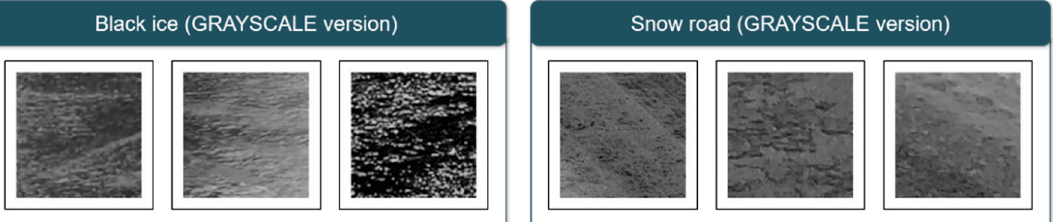
Figure 8. GRAYSCALE version of train data (black ice and snow road); relative to the data in the previous figure, the reflection of black ice and snow crystals and slush are not clearly identified.